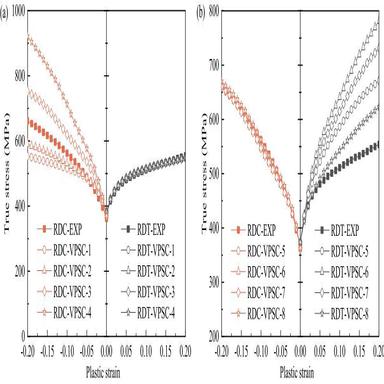
Comparison of the experimental and the predicted results: (a) tension-based optimization; (b) compression-based optimization, indicating that the single object optimization based calibration cannot capture the T-C asymmetry of flow stress.